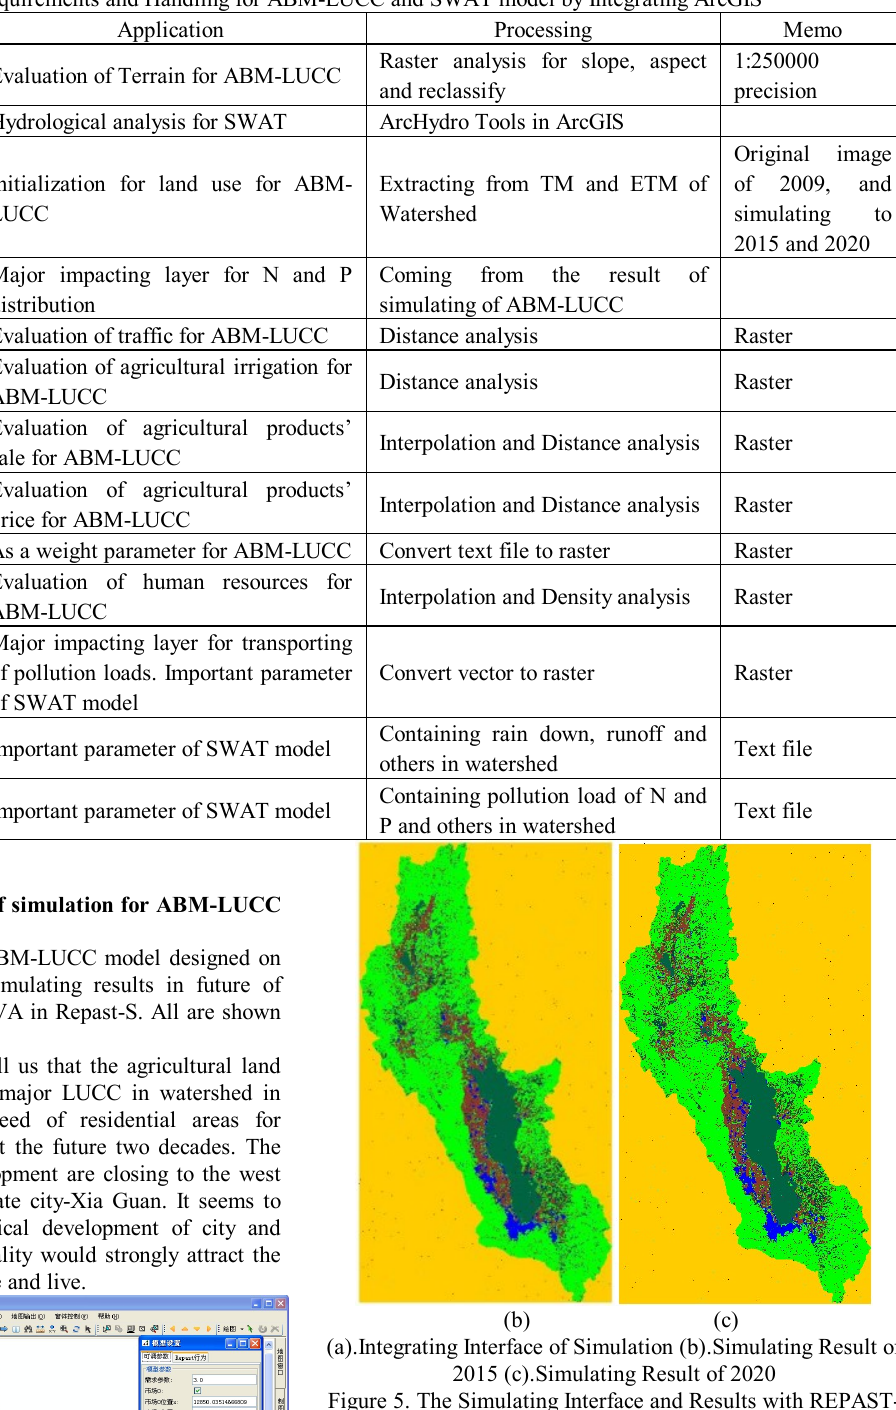
Figure 5. The Simulating Interface and Results with